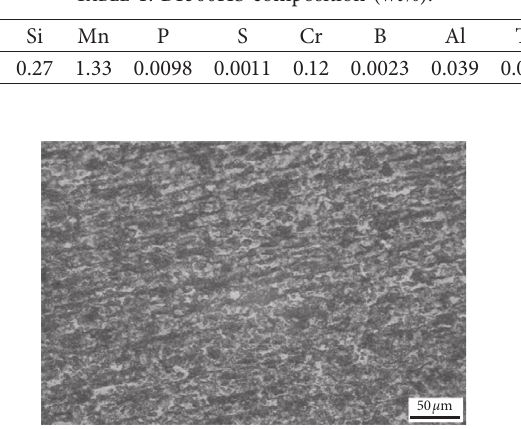
Figure 1: Microstructure of BR1500HS boron alloy steel at room